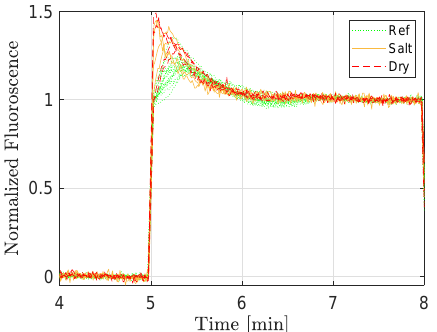
Figure 4. The fluorescence response of the first excitation for all biotic stress experiments on lettuce ‘a’. Green dotted lines: healthy reference plants. Orange solid lines: salt-stressed plants. Red dashed lines: drought-stressed